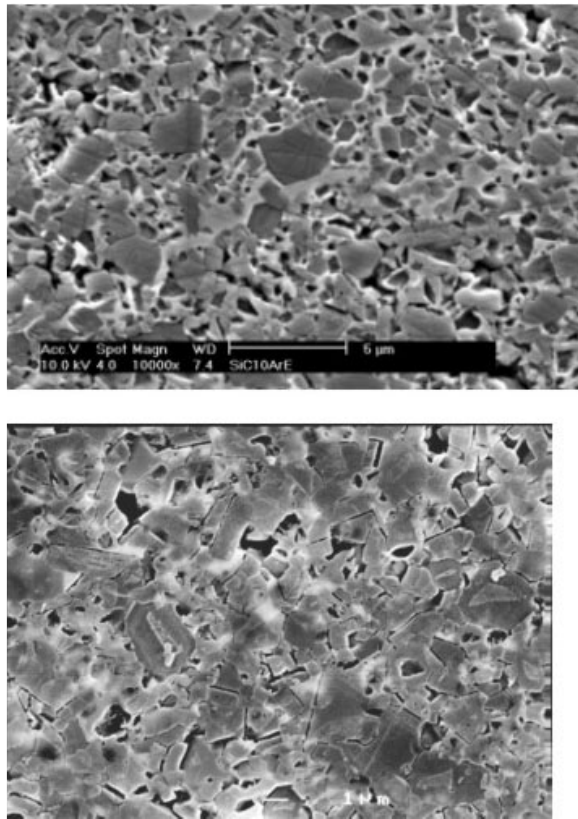
Figure 11. Microstructures of the (a) as-sintered (1 h at 1950 °C in Ar atmosphere) and (b) annealed (8 h at 1900 °C, N 2 atmosphere) SiC-AlN- Y 2 O 3 chemically etched